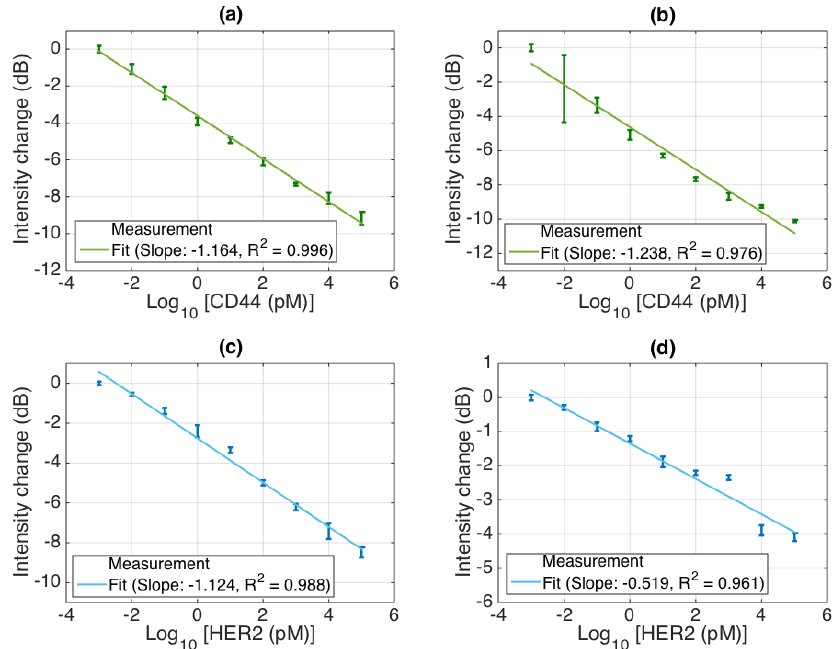
Figure 12. Detection of cancer biomarkers with BR sensors, using a simultaneous four-sensor network. Each chart reports the experimental data, sampling the concentrations from 1 fM to 100 nM with a 10 × increment; error bars report ± standard deviation of 6 consecutive measurements, acquired after 10 min stabilization and sampled at each 2 min interval. Solid lines report the log-linear fit; the slope reports the intensity change (in dB units) recorded for each 10 × increment of concentration. ( a ) First CD44 sensor; ( b ) second CD44 sensor; ( c ) first HER2 sensor; ( d ) second HER2 sensor.